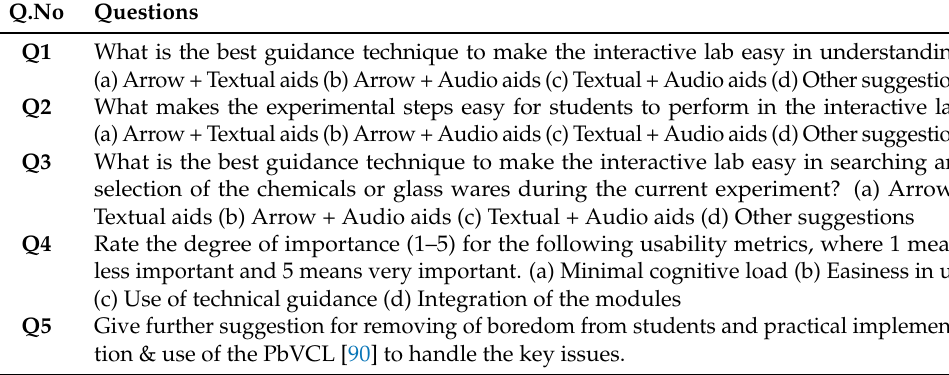
Figure 4. The existing virtual lab with aids; ( a ) represents textual instructions and ( b ) represents arrow [90]. Table 8. Questionnaire interview from field